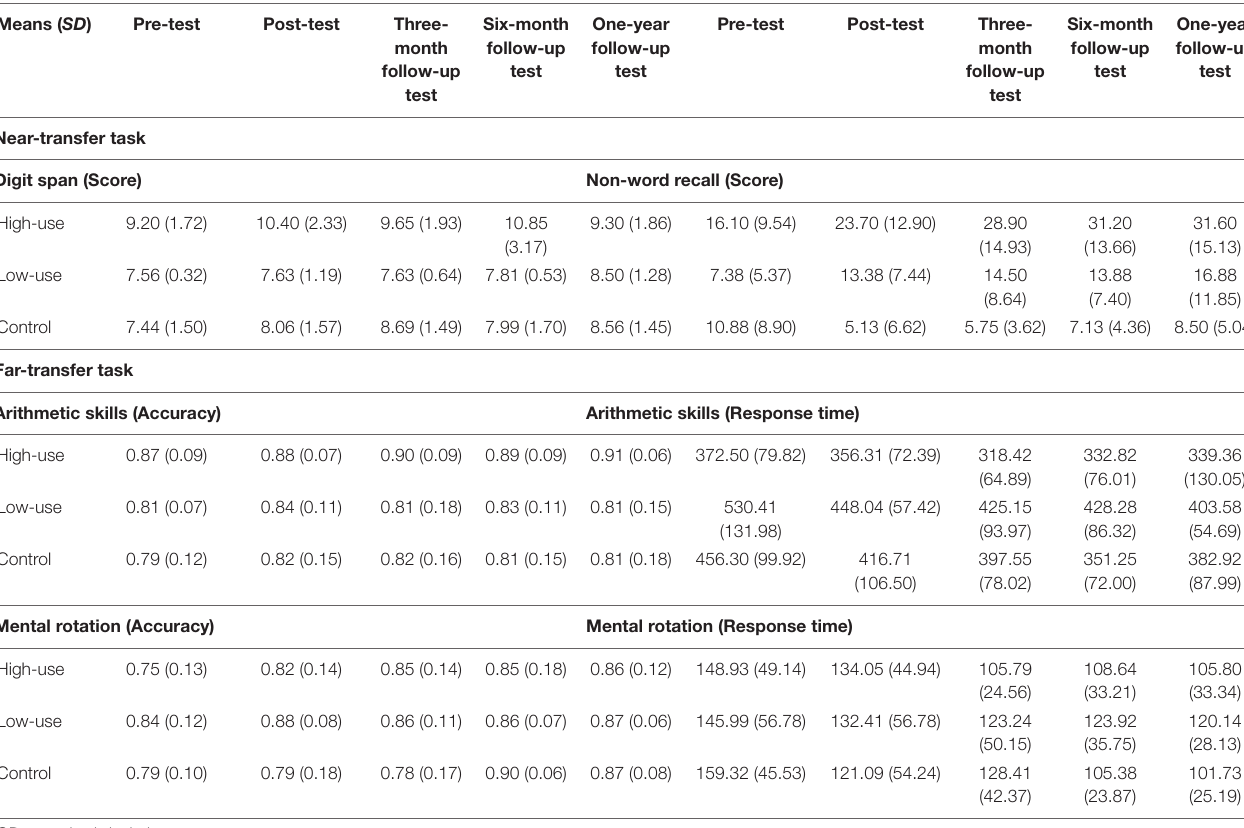
TABLE 6 | Means (standard deviations) of individual tasks in Experiment